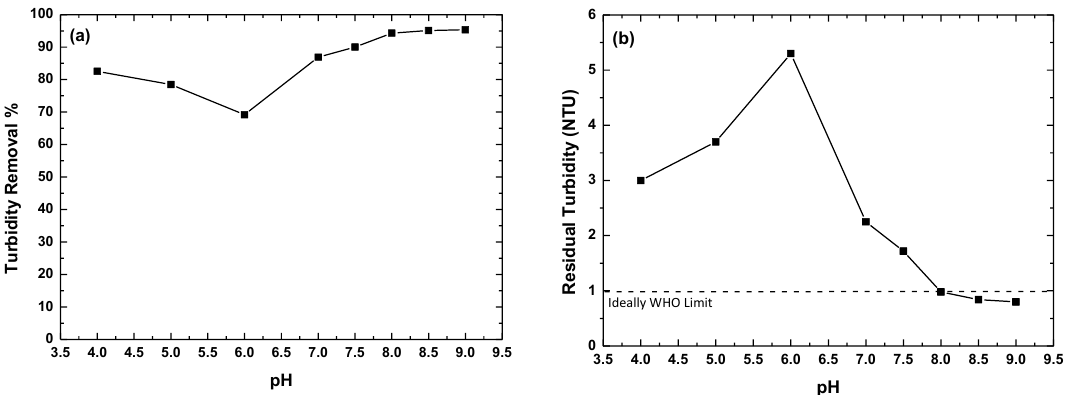
Figure 6. E ff ect of pH values on ( a ) % turbidity removal, ( b ) residual turbidity, when treating simulated surface water samples, for an initial turbidity of 17.2 NTU and coagulant dosage of 10 mg / L, regarding the application of the optimal GO-PFSiC 1.5-15-0.5 material.